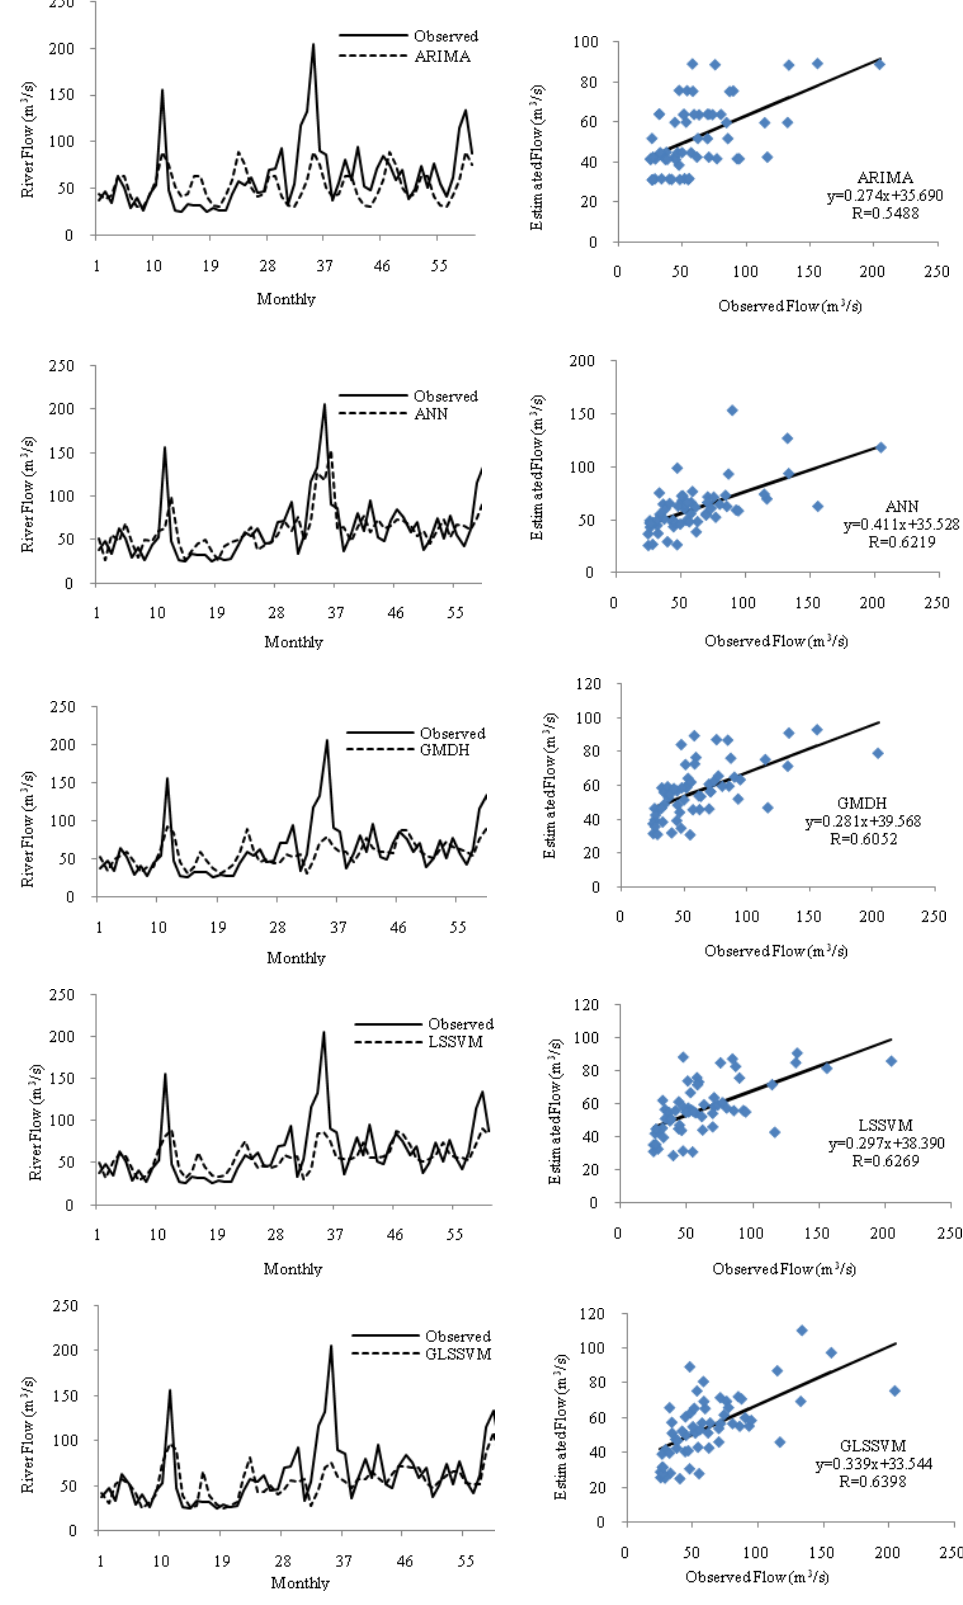
Fig. 9. Comparison of the testing results of ARIMA, ANN, GMDH, LSSVM and GLSSVM models for Selangor river.